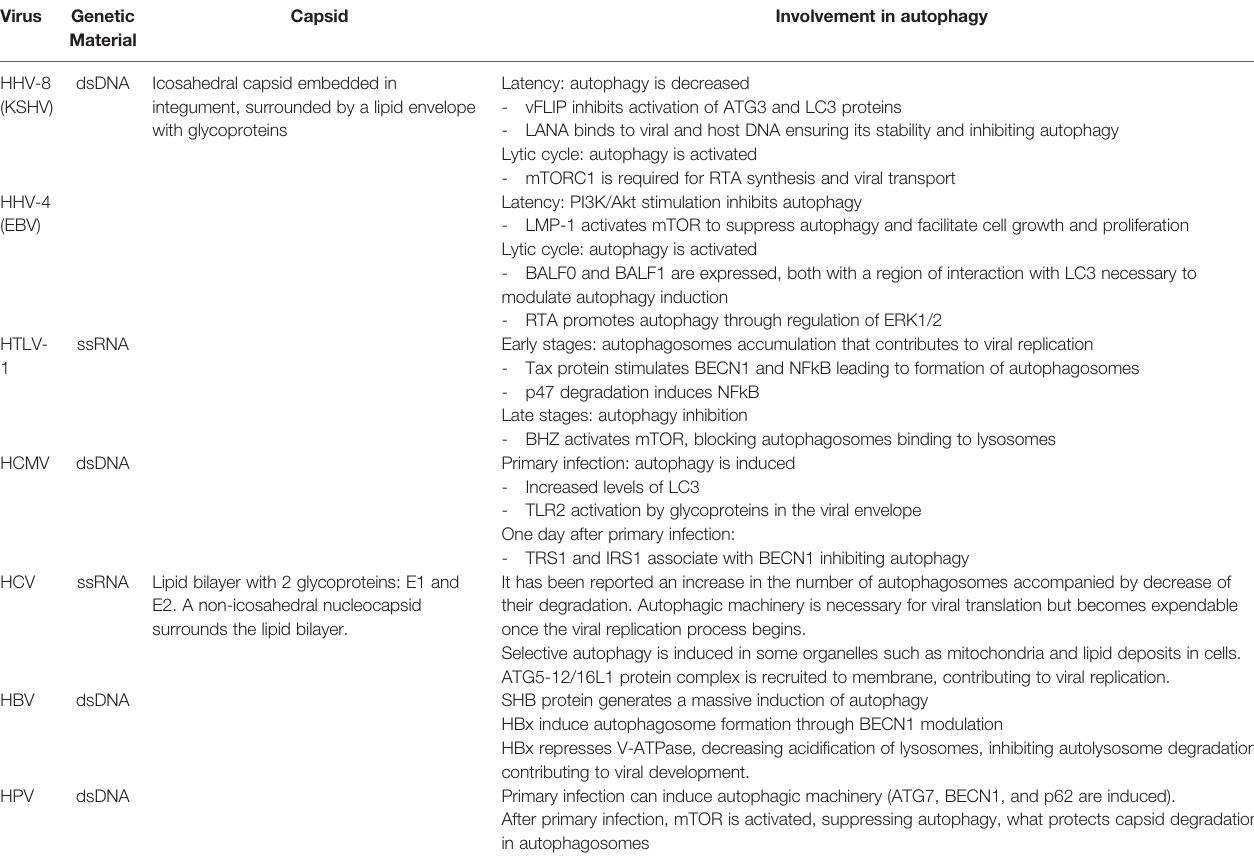
TABLE 1 | Oncogenic viruses and their involvement in autophagy. Virus Genetic